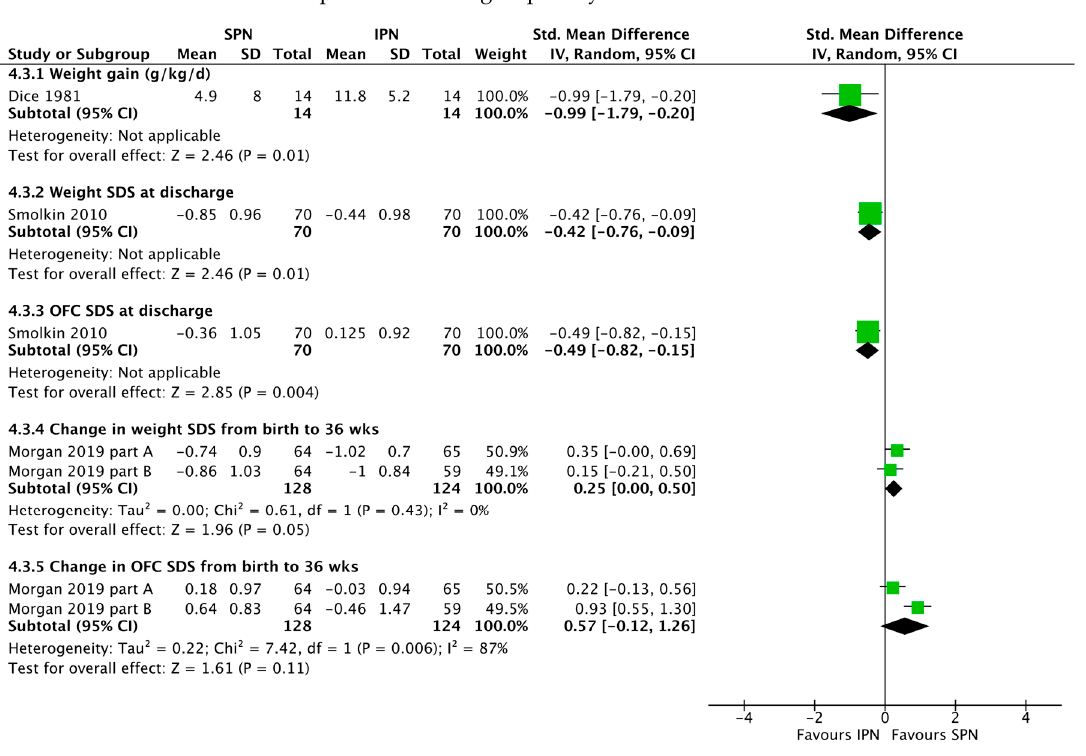
Figure 4. Forest plot on the effect of standardized parenteral nutrition (SPN) vs. individualized parenteral nutrition (IPN) on duration of PN (days). Green squares represent individual studies, the diamond represents the subgroup analysis.